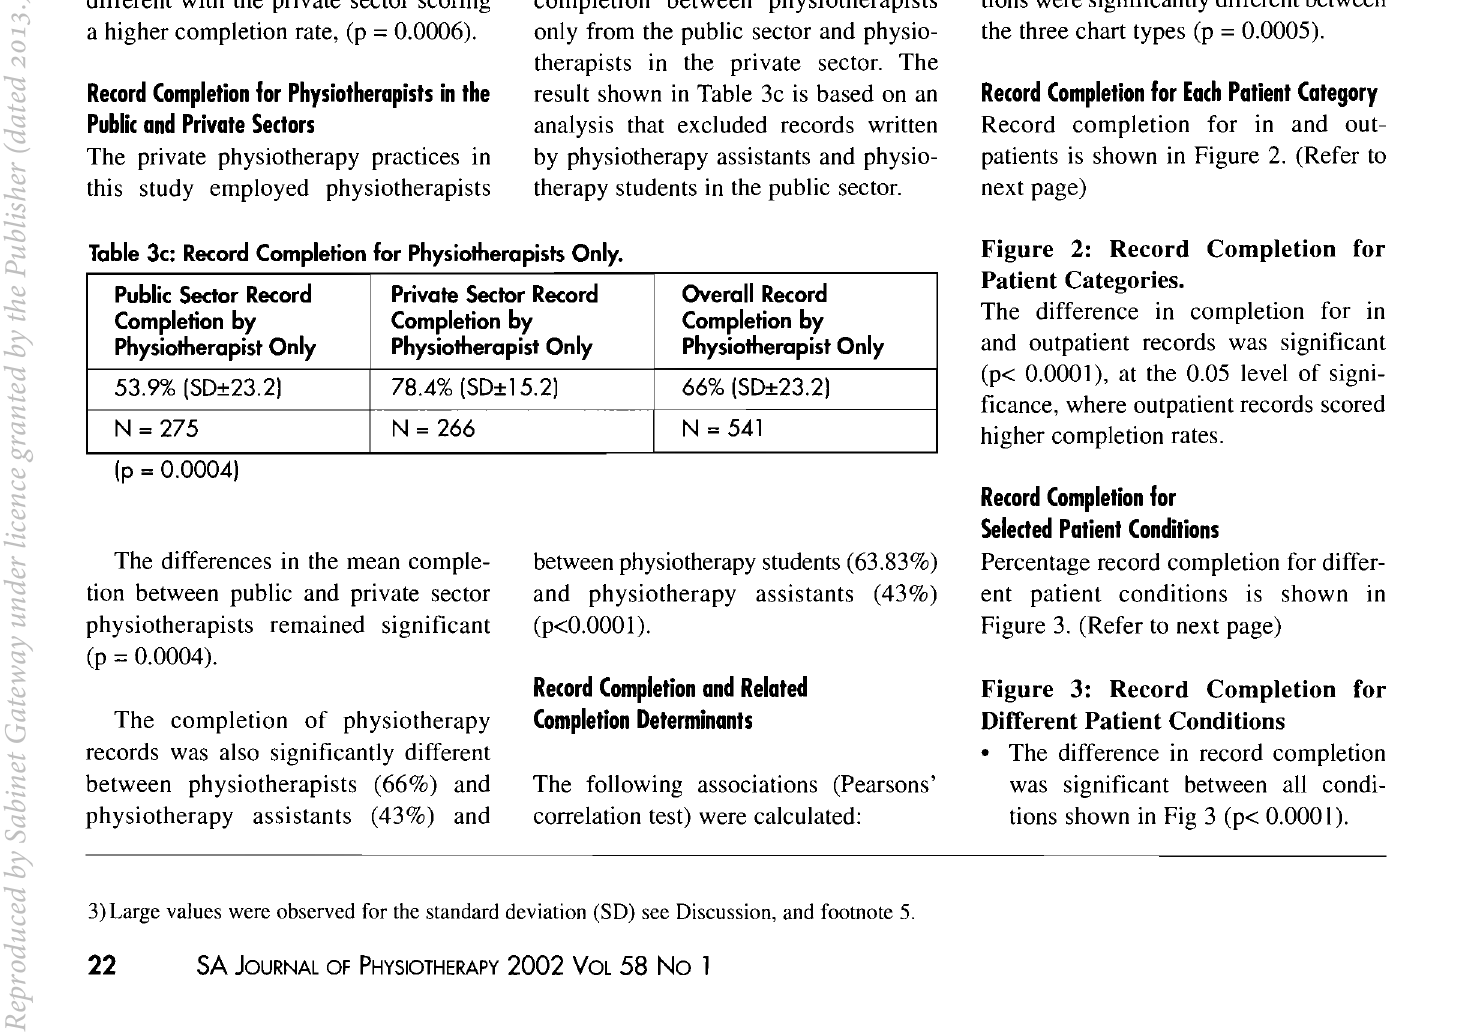
Table 3c: Record Completion for Physiotherapists